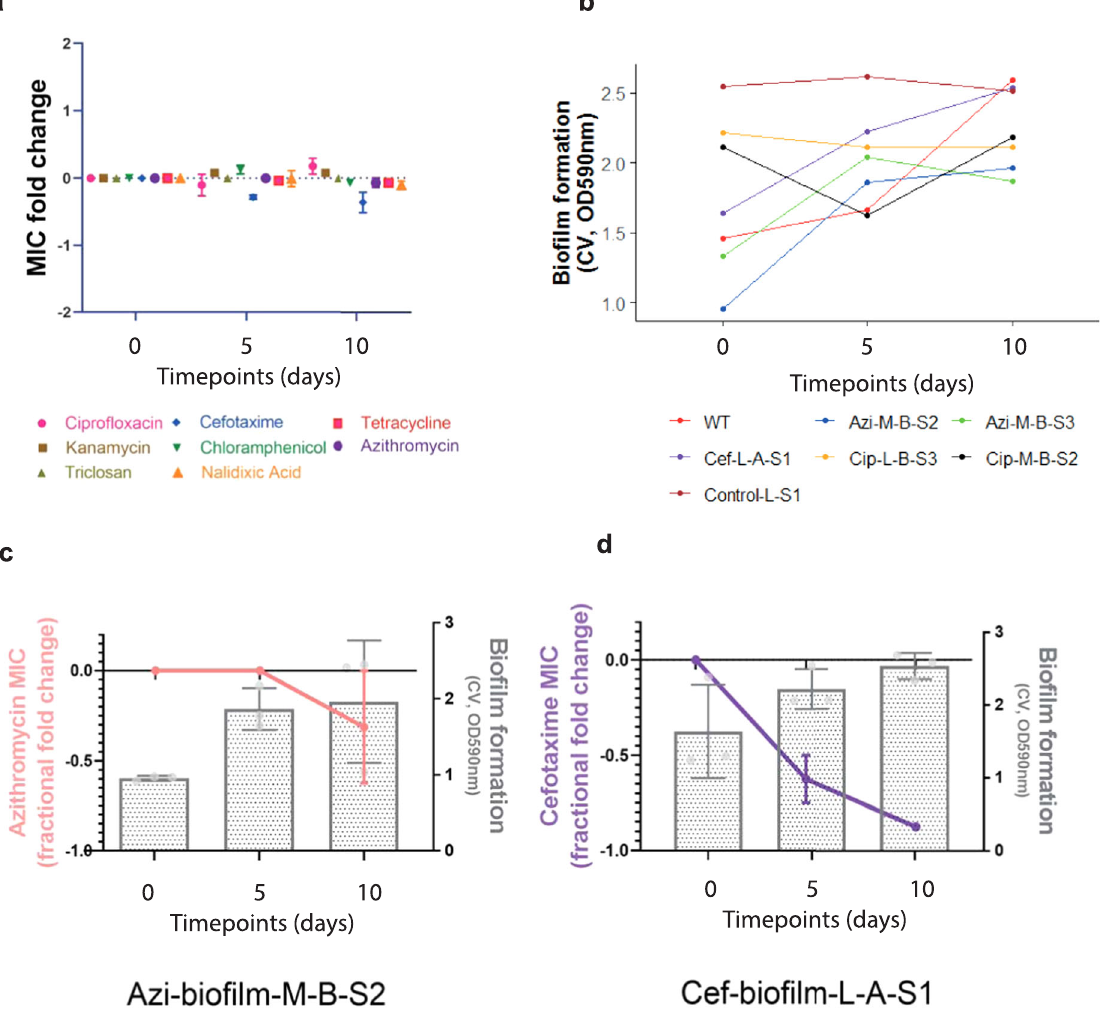
Fig. 6 Stability of resistance. a Average fold change in MIC per antibiotic for seven strains was calculated after ten 24-h passages without any stressor present. For most antibiotics, resistance was stable throughout the accelerated evolution experiment, except for cefotaxime. Dots show the average fold change in MIC derived from three isolates and error bars show ±one standard error. b Bio fi lm formation increased for most of the tested strains, by the end of the experiment. Points represent modelled means in each exposure that represent the estimated proportion of cells present at each time point for each strain. c Individual example of an azithromycin-resistant strain, which adapted and formed better bio fi lm over time without losing resistance to azithromycin. Pink line shows the changes in azithromycin MIC over time (line graph, left axis). Bars (bar chart, right axis) show the average bio fi lm formation from three replicates. Error bars indicate standard deviation. d Individual example of a cefotaxime-resistant strain, which adapted to forming better bio fi lm but lost the resistance to cefotaxime. Purple line shows the changes in cefotaxime MIC over time (line graph, left axis). Bars and error bars are as